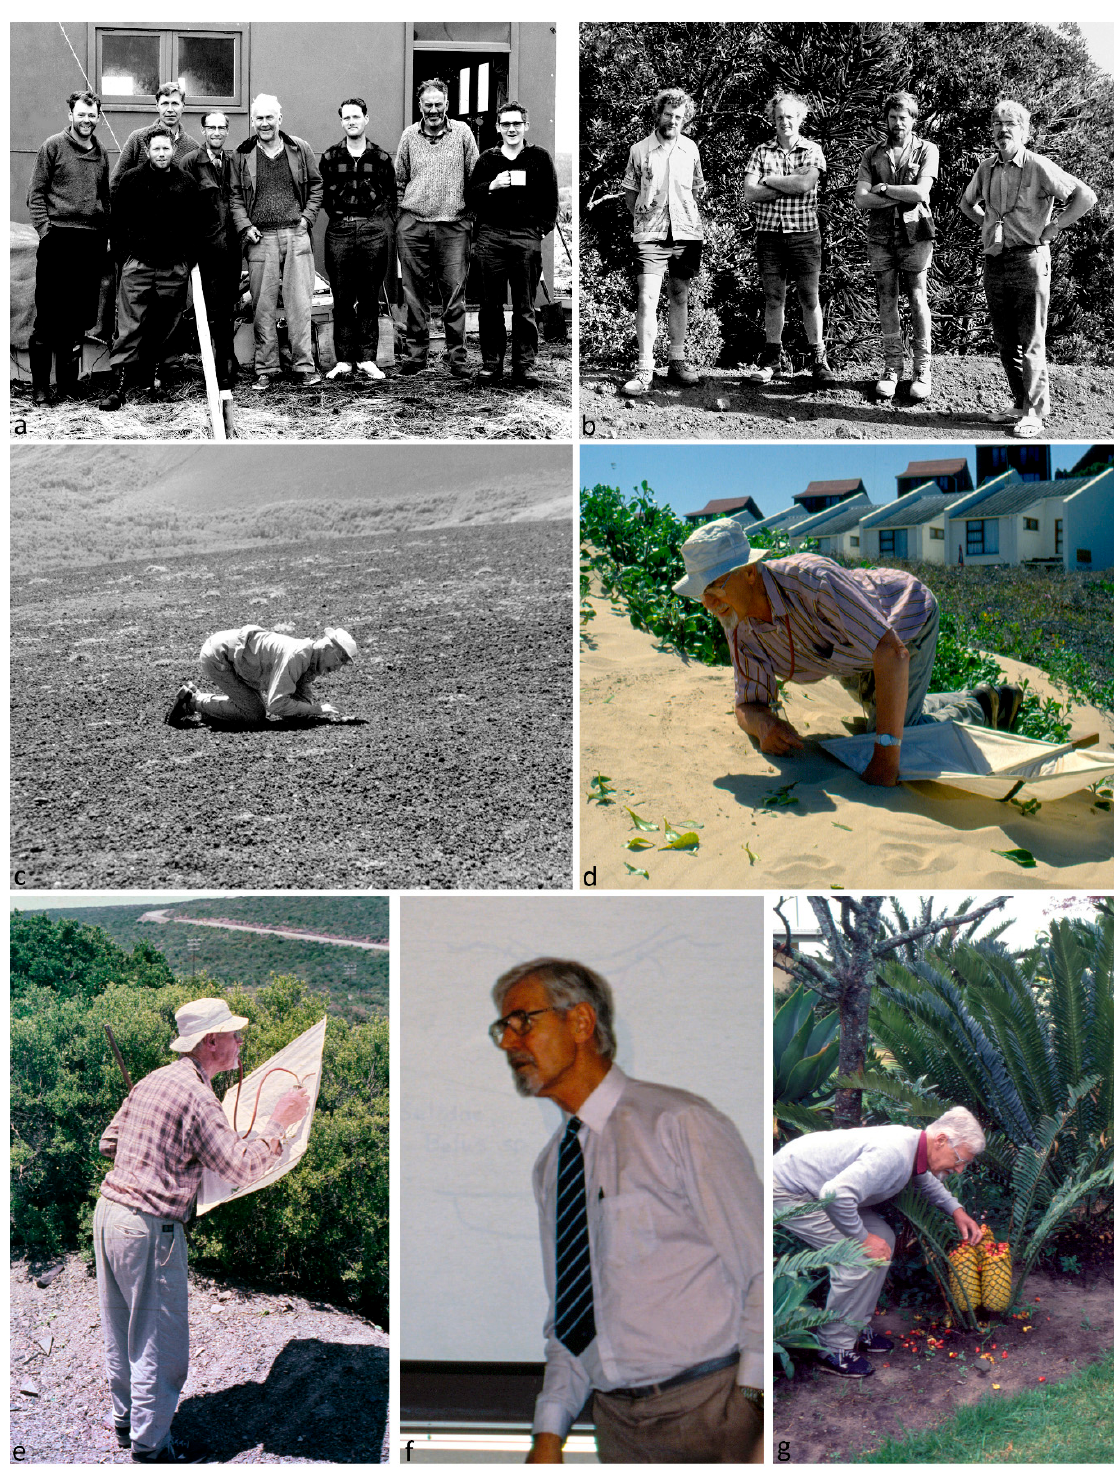
Figure 2. Willy Kuschel in action: ( a ) University of Canterbury Antipodes Expedition, 1969 (f.l.t.r. Rowley H. Taylor, Brian Bell, Guillermo Kuschel, John Warham, Eric Godley, Ian Mannering, Robert Stanley, Peter M. Johns) (photo: John Warham); ( b ) New Caledonia, 1978 (f.l.t.r. Charles Watt, John Dugdale, Peter Johnson, Guillermo Kuschel) (photo: Ken Fox); ( c ) investigating alpine plants, Antillanca, southern Chile, February 1997 (photo: Gerda Kuschel); ( d ) Port Alfred, South Africa, November 1992 (photo: RGO); ( e ) collecting the rare Hispodes spicatus , Ecca Pass, South Africa, November 1992 (photo: RGO); ( f ) lecturing at the I.C.E. weevil symposium in Vancouver, July 1988 (photo: RGO); ( g ) inspecting a cycad cone, Komga, South Africa, November 1992 (photo: RGO).